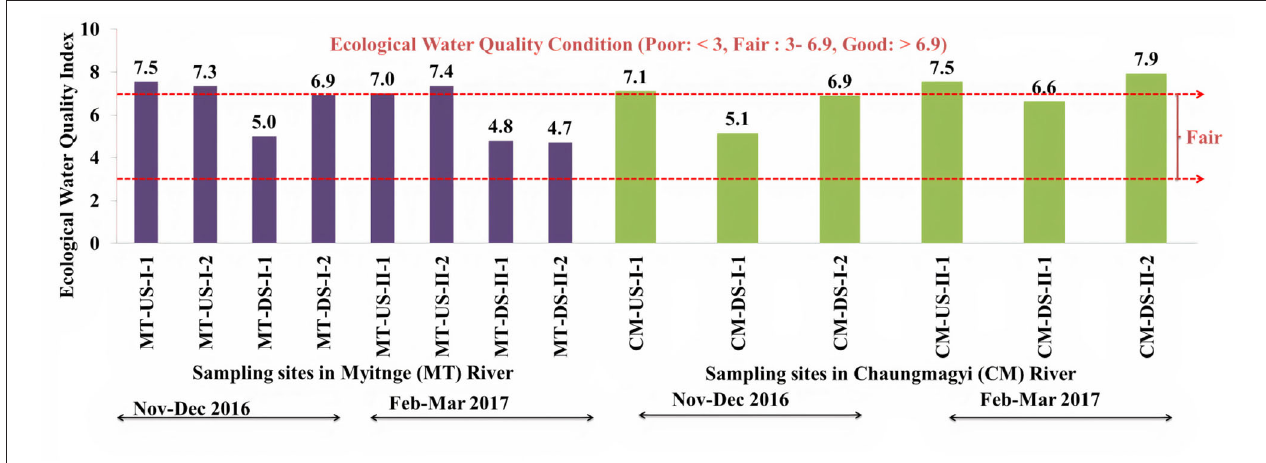
II-second sampling period (February–March